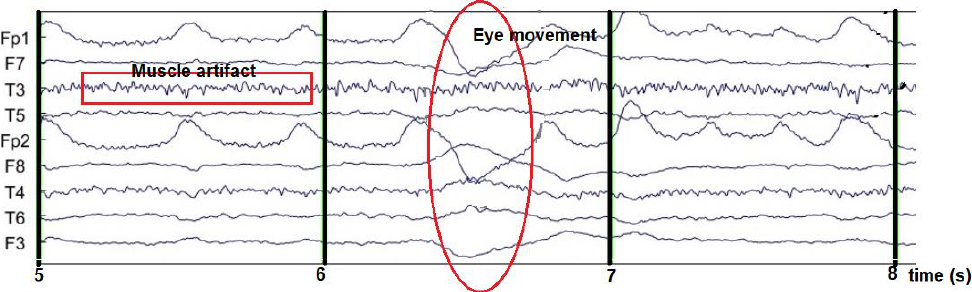
Figure 5. EEG signal contaminated with Figure 5 . EEG signal contaminated with noise .